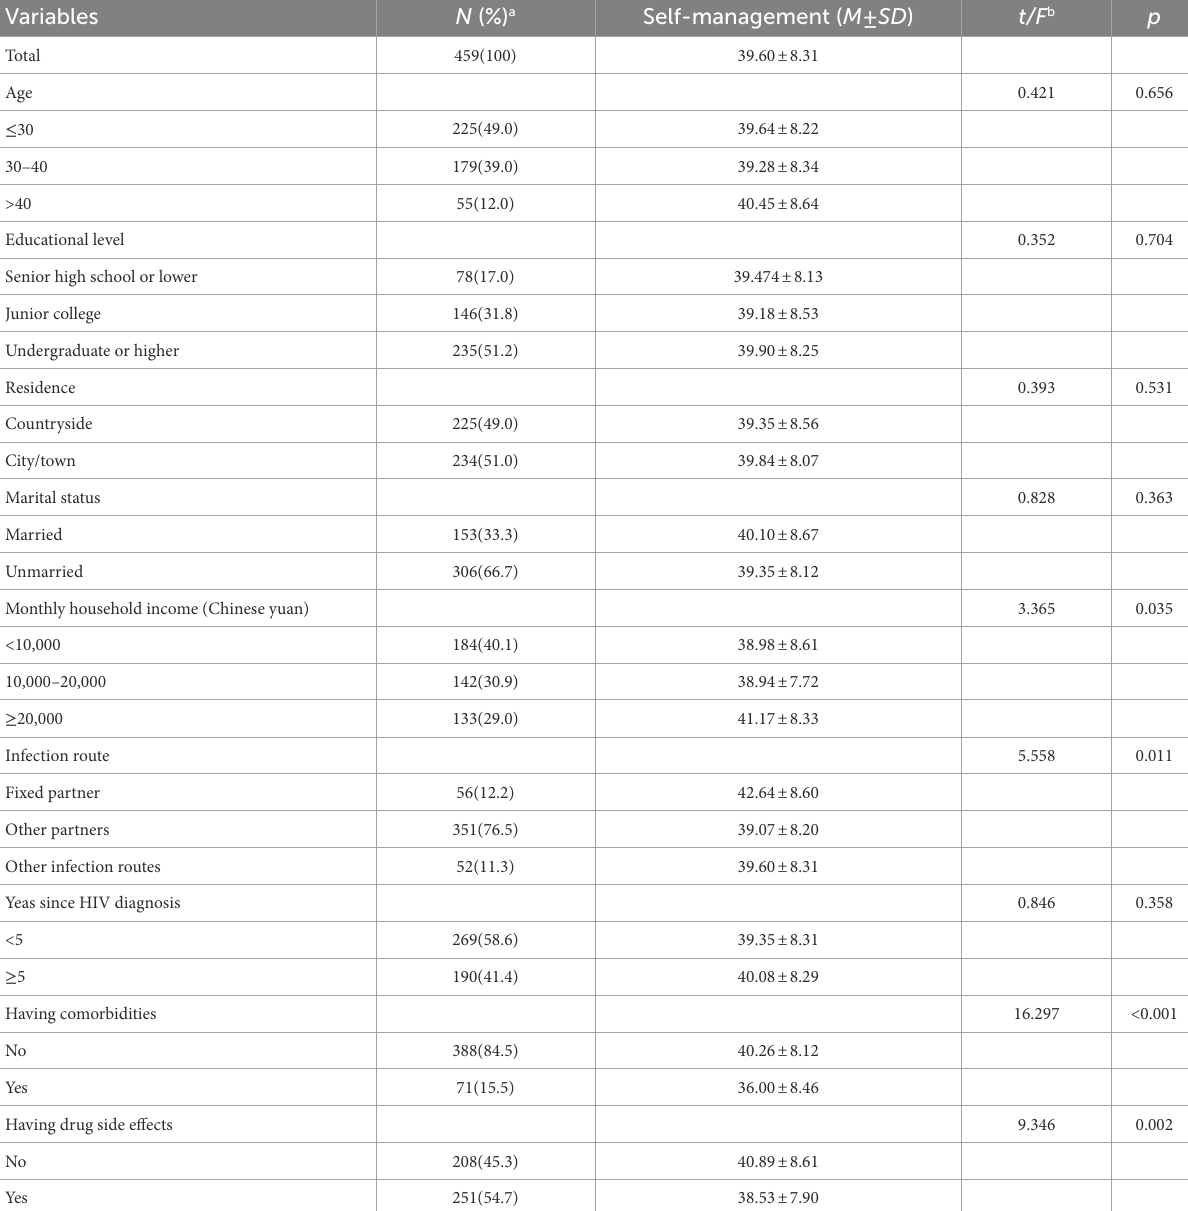
TABLE 1 Baseline characteristics and difference in the score of HIV